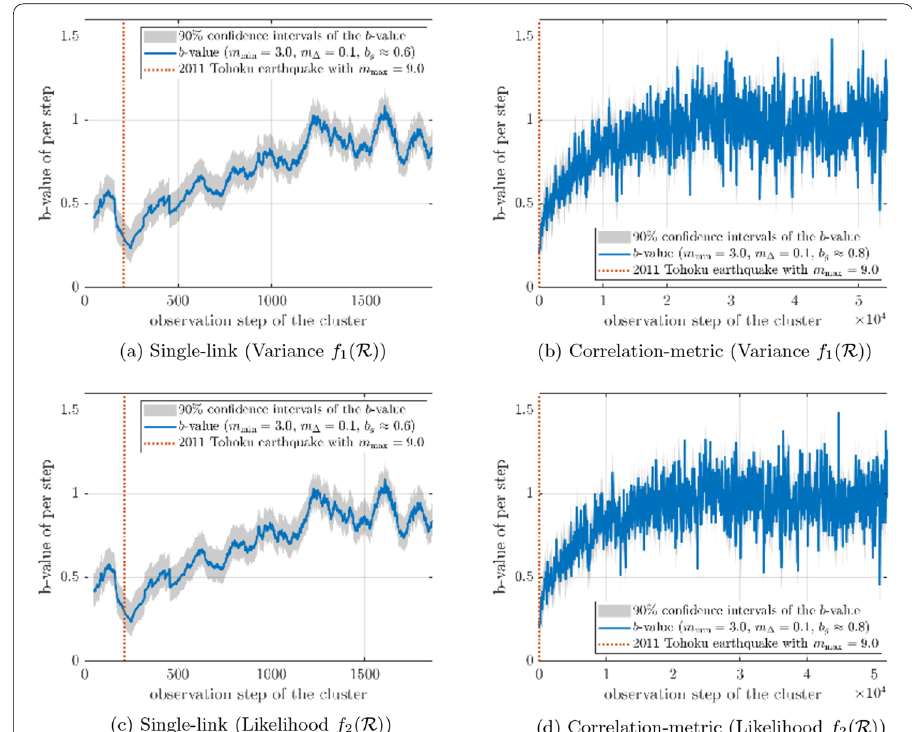
Fig. 7 Results of b -value of the clusters which has the largest magnitude m max = 9.0 (when the number of clusters G = 8